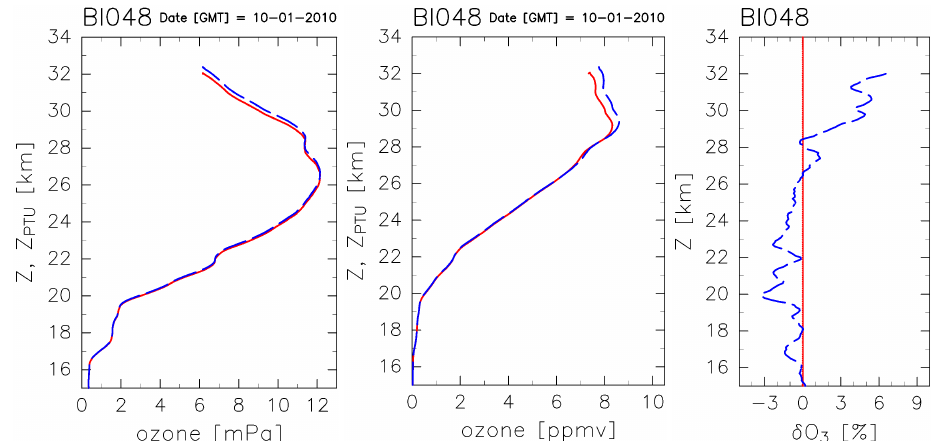
Figure 5. As for Fig. 3 but for (left) ozone partial pressure ( p O 3 (Z PTU ) ≡ p O 3PTU (Z) shown by blue dashed line and p O 3 (Z) by the red line) and (center) ozone mixing ratio ( χ O 3 (Z PTU ) ≡ χ O 3PTU (Z) shown by the blue dashed line, and χ O 3 (Z) by the red line). (Right) Difference in the ozone profiles for partial pressure and mixing ratio ( p O 3 PTU (Z) minus p O 3 (Z) or χ O 3 PTU (Z) minus χ O 3 (Z) ; blue dashed line).